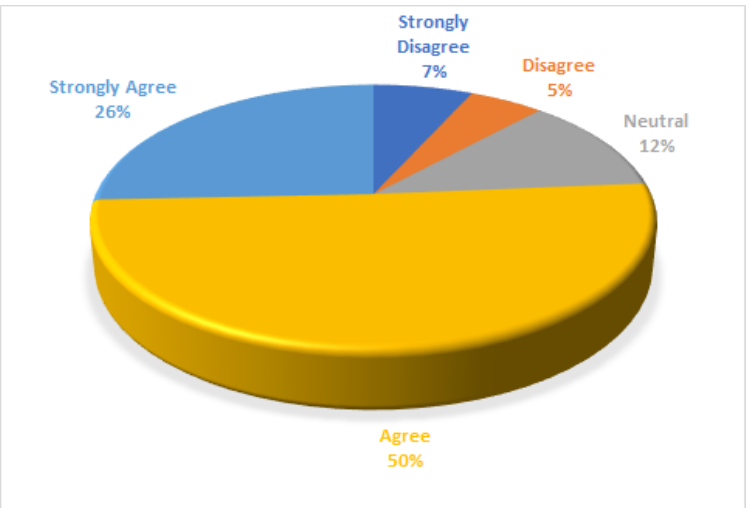
Figure 4. Answers to a Likert five-point scale to the question: Do you think this activity (dEER) has helped you reinforce the knowledge related to the